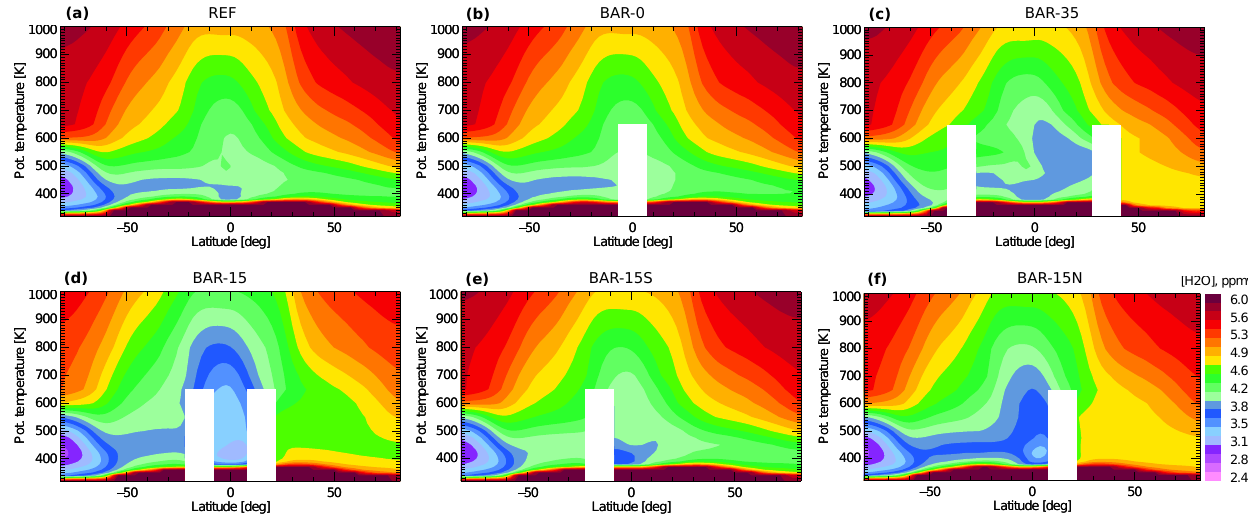
Figure 8. Zonal mean water vapour distributions for 2011. Shown data are from the CLaMS sensitivity simulations for the reference (a) and the horizontal transport barrier simulations along latitude circles at 0 ◦ (b) , 35 ◦ N/S (c) , 15 ◦ N/S (d) , 15 ◦ S (e) and 15 ◦ N (f) . Transport barriers are set between the Earth’s surface and the 600K potential temperature levels and are represented in